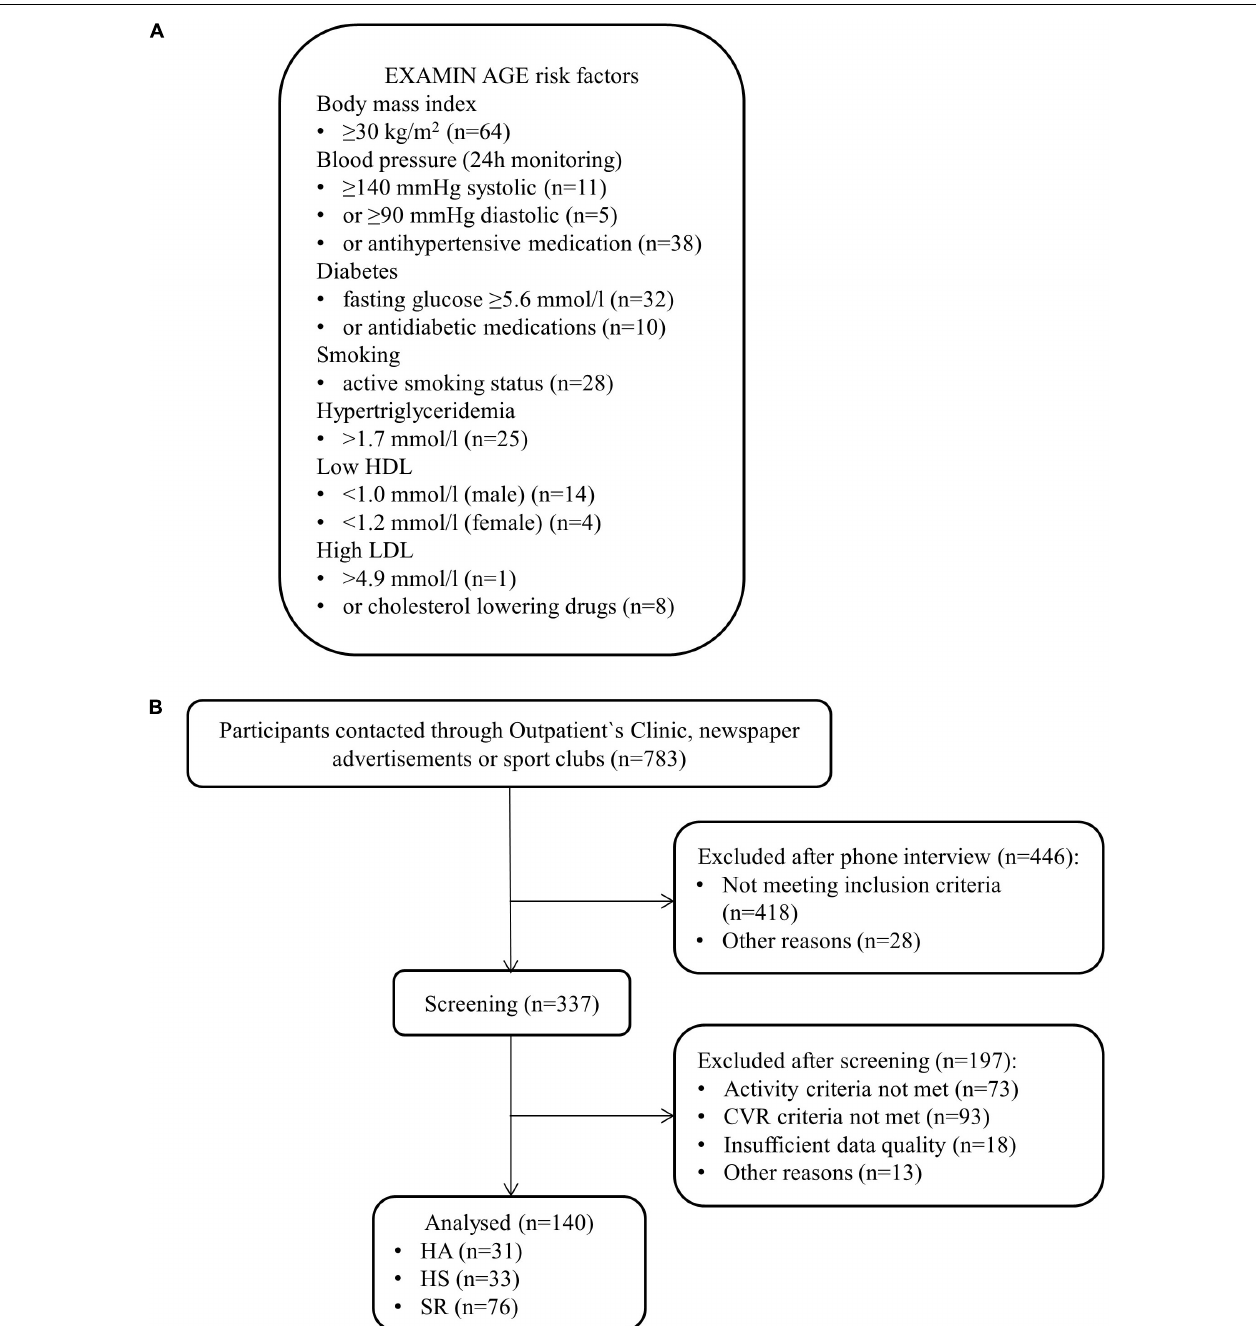
FIGURE 1 | Cardiovascular risk factors (A) and flow-chart (B)